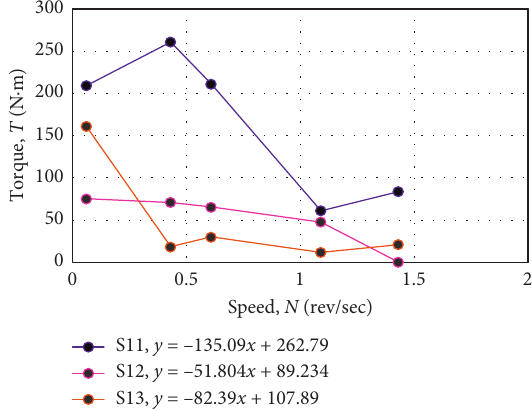
Figure 9: Power consumption for M30 grade concrete.